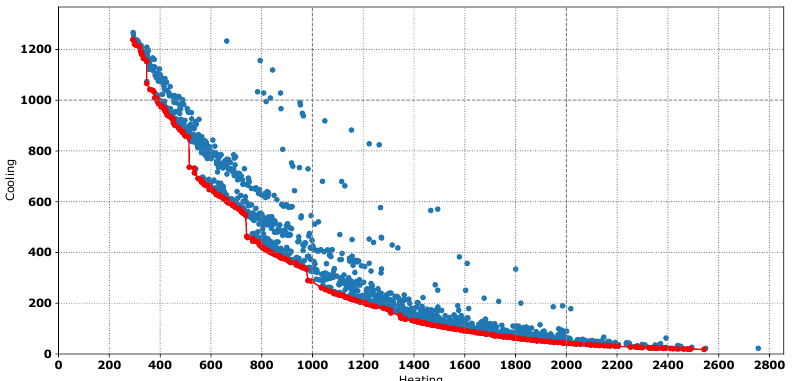
Figure 5. Pareto frontier (heating and cooling).